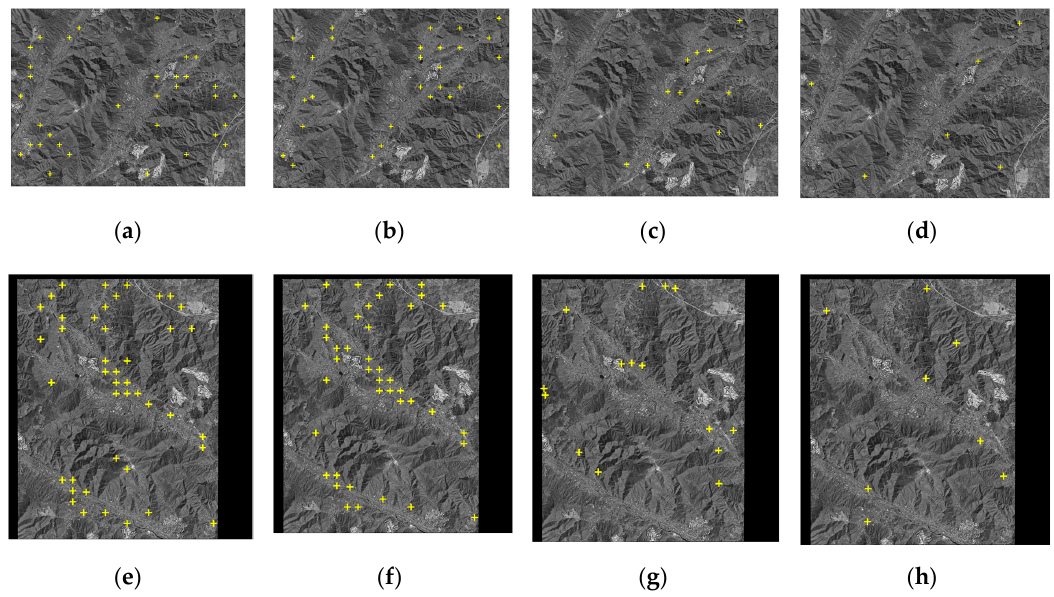
Figure 11. Visual expression of the extracted conjugate points overlaid on K3-944 image (template size: 500 × 500 pixels): ( a ) phase correlation (PC), ( b ) mutual information (MI), ( c ) speeded up robust features (SURF), and ( d ) HARRIS–fast retina keypoint (FREAK) applied to the original image, and ( e ) PC, ( f ) MI, ( g ) SURF, and ( h ) HARRIS–FREAK applied to the coarse epipolar image.